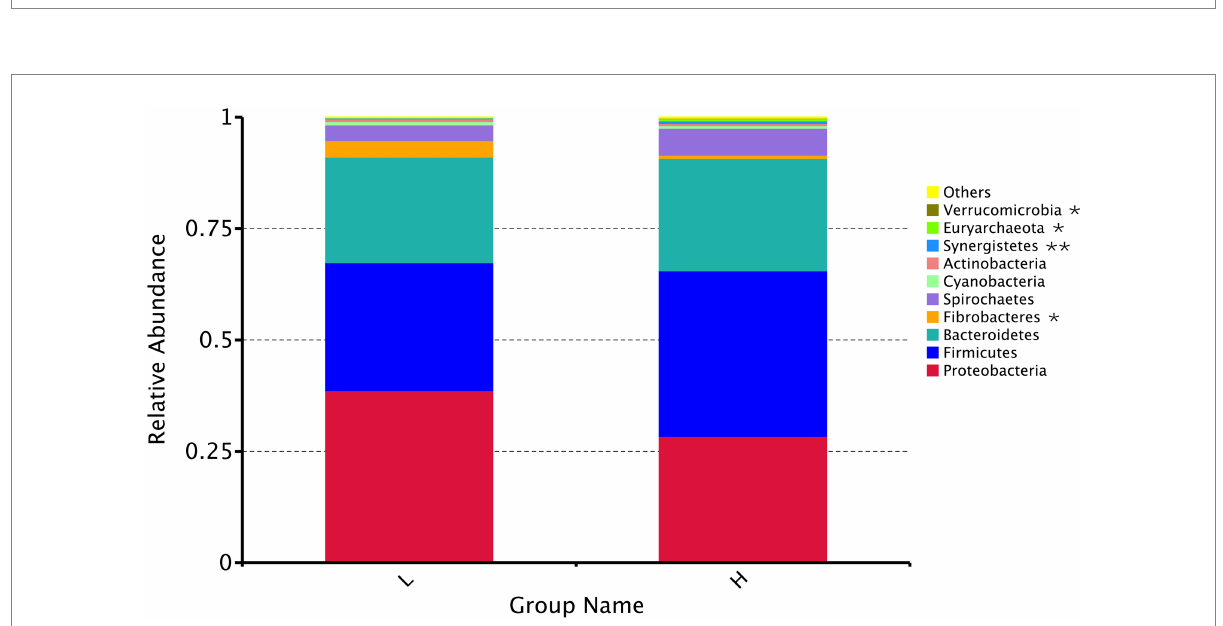
FIGURE 4 Relative abundance of the top 10 rumen microbial compositions at the phylum level. H: high MR feeding level group, fed MR at 4% DM/kg of average body weight per day; L: low MR feeding level group, fed MR at 2% DM/kg of average body weight per day. * indicates a significant difference ( p < 0.05), and ** indicates an extremely significant difference ( p < 0.01) between two groups.